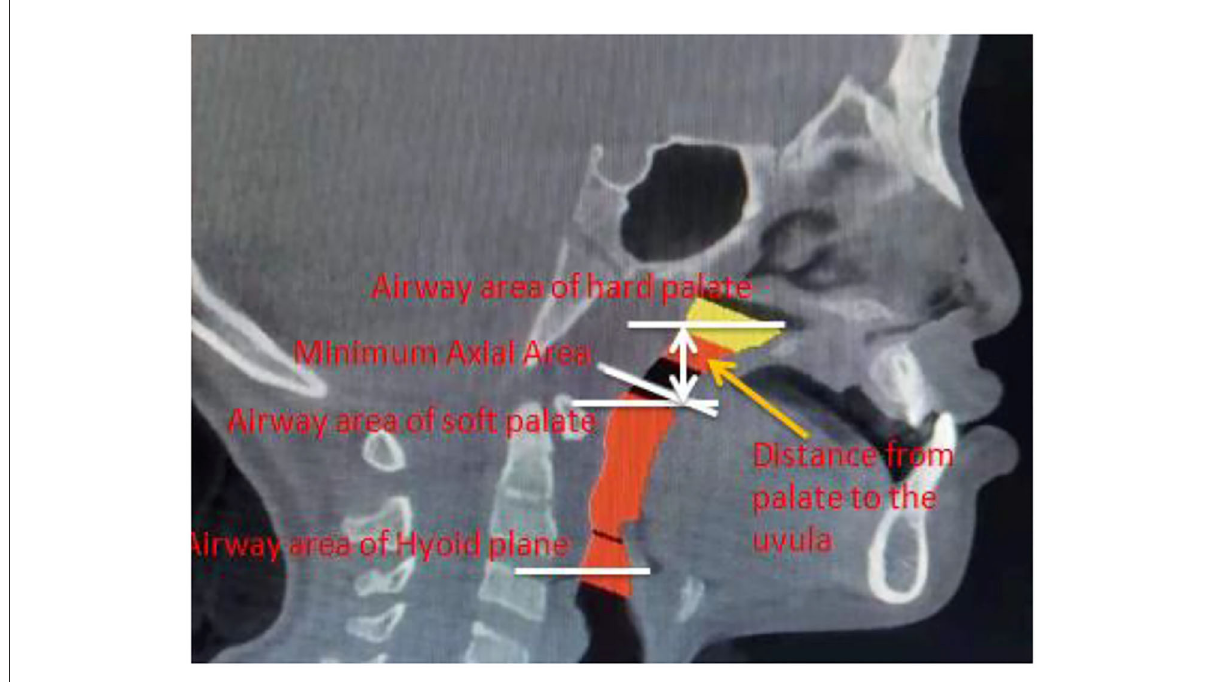
FIGURE1 Airway volume and measurement plane of the